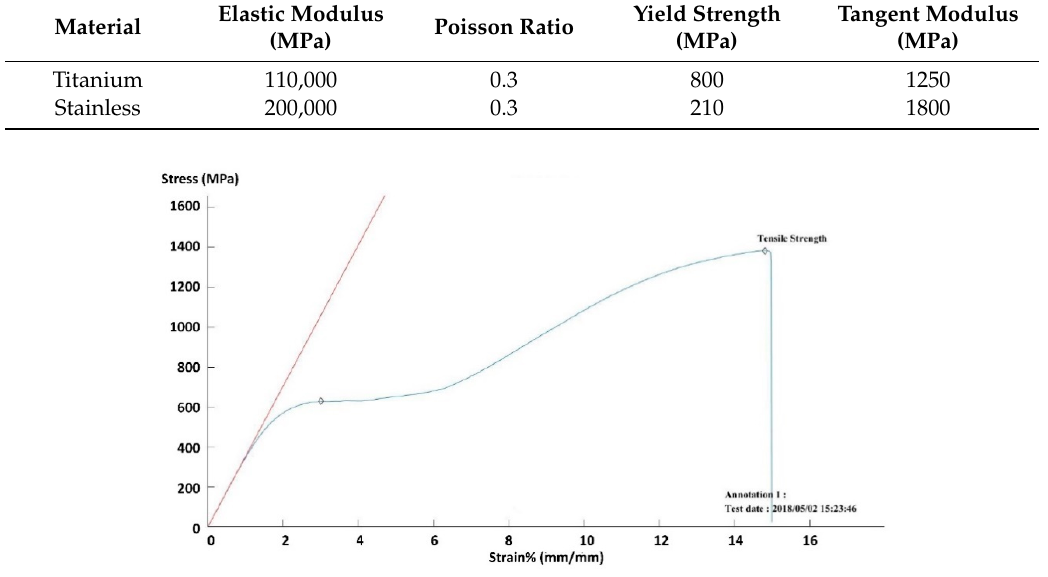
Figure 3. Relationship between the stress and strain of Nitinol rod used in this study.